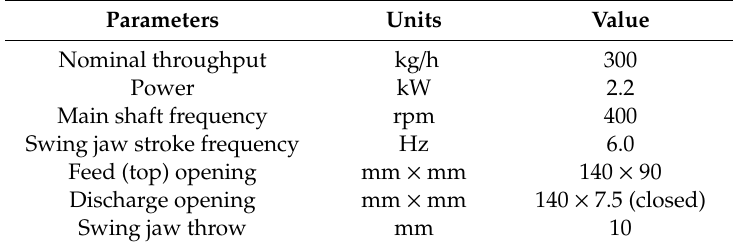
Table 2. Operational parameters used in the laboratory-scale jaw crushing experimental tests Parameters